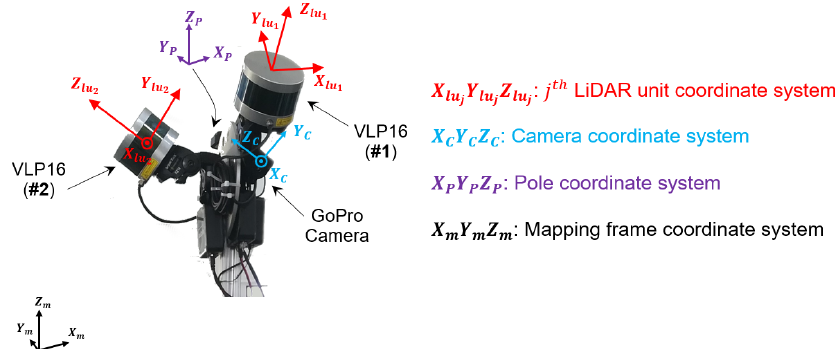
Figure 3. Illustration of the involved coordinate systems in the SMART system.